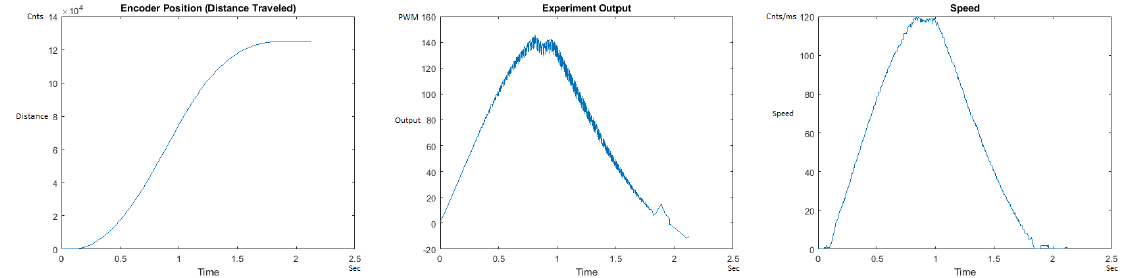
Figure 14. Encoder position, output and speed plots for PID++ UP operation— Vmax 30 cnts/ms, Adesired 0.055 cnts/ms 2 — 1 Kg.